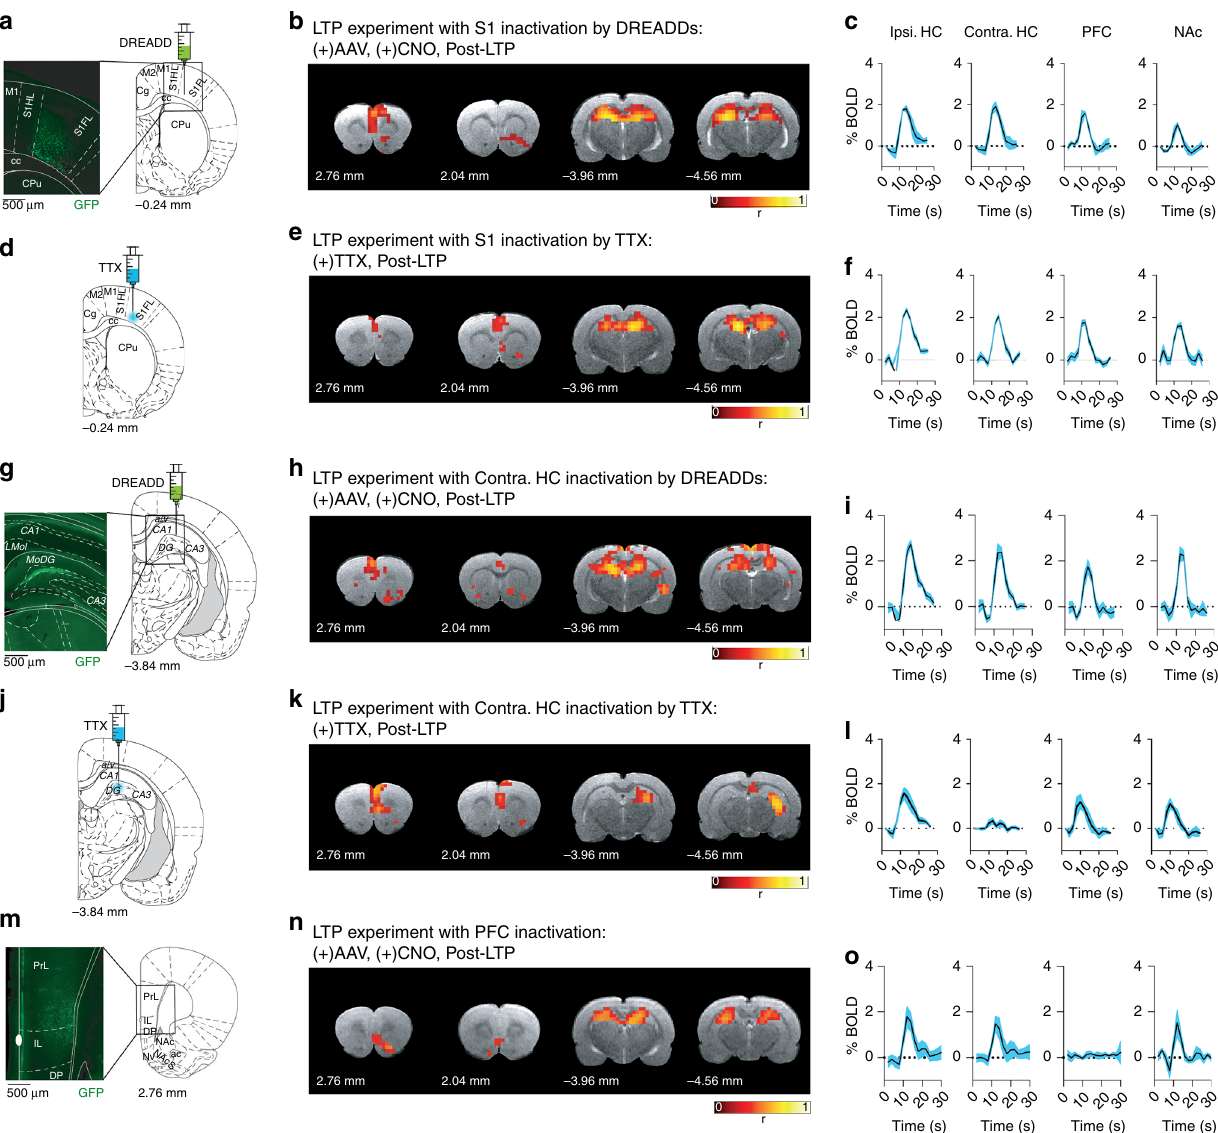
Fig. 5 Targeted inactivation of different brain regions. a – c Pharmacogenetic inactivation of S1 cortex. a Location of the AAVs injection in the corresponding section of the stereotaxic map and representative histological staining showing the construct expression (inset). b Shows the statistically thresholded ( p < 0.001, corrected) fMRI maps of a representative animal and c the averaged BOLD signals across subjects ( n = 2) and across region of interest. As in Fig.